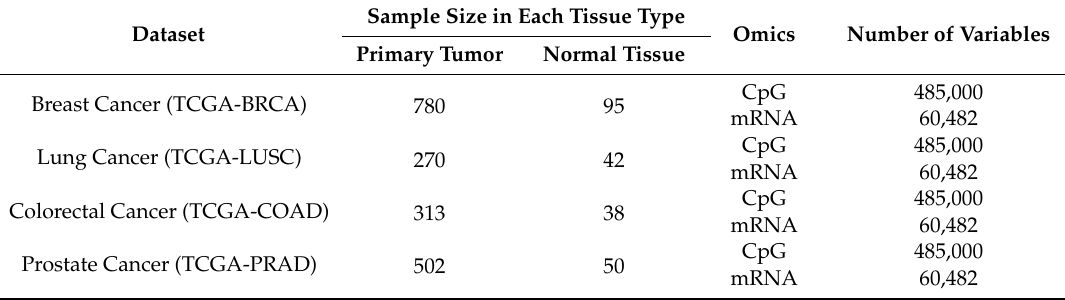
Table 2. Overview of multi-omics datasets analyzed in this